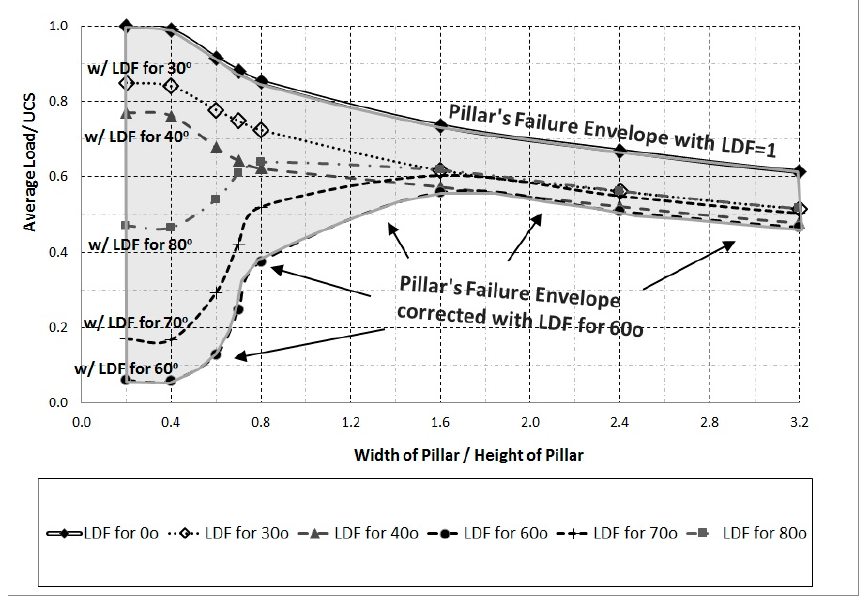
Figure 8. Pillar stability curves with varying LDF factor, H p = 10 m.